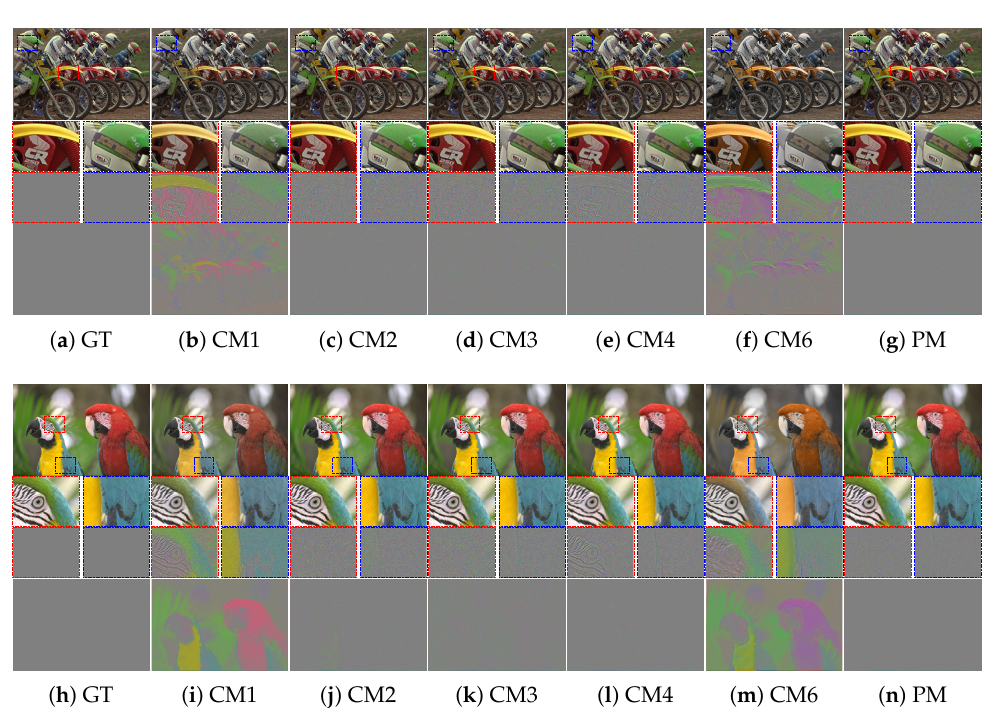
Figure 6. Visual comparison of restored images, enlarged parts, and difference maps from crosstalk degradation 1 (crosstalk kernel with σ g = 0.45 and noise with σ n = 0.01): ( a ) Ground truth, ( b ) CM1, ( c ) CM2, ( d ) CM3, ( e ) CM4, ( f ) CM6, and ( g ) PM. ( h – n ) Same methods as in ( a – g ). The first and second rows present the results of Bike and Parrot in the Kodak dataset,